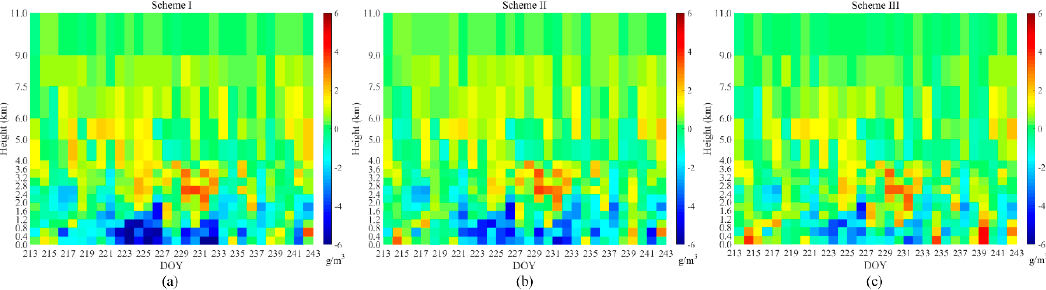
Figure 17. The mean differences between the tomographic results and radiosonde data along the radiosonde vertical columns from DOY 213 to DOY 243, 2017. (a) Scheme I; (b) Scheme II; and (c) Scheme III.